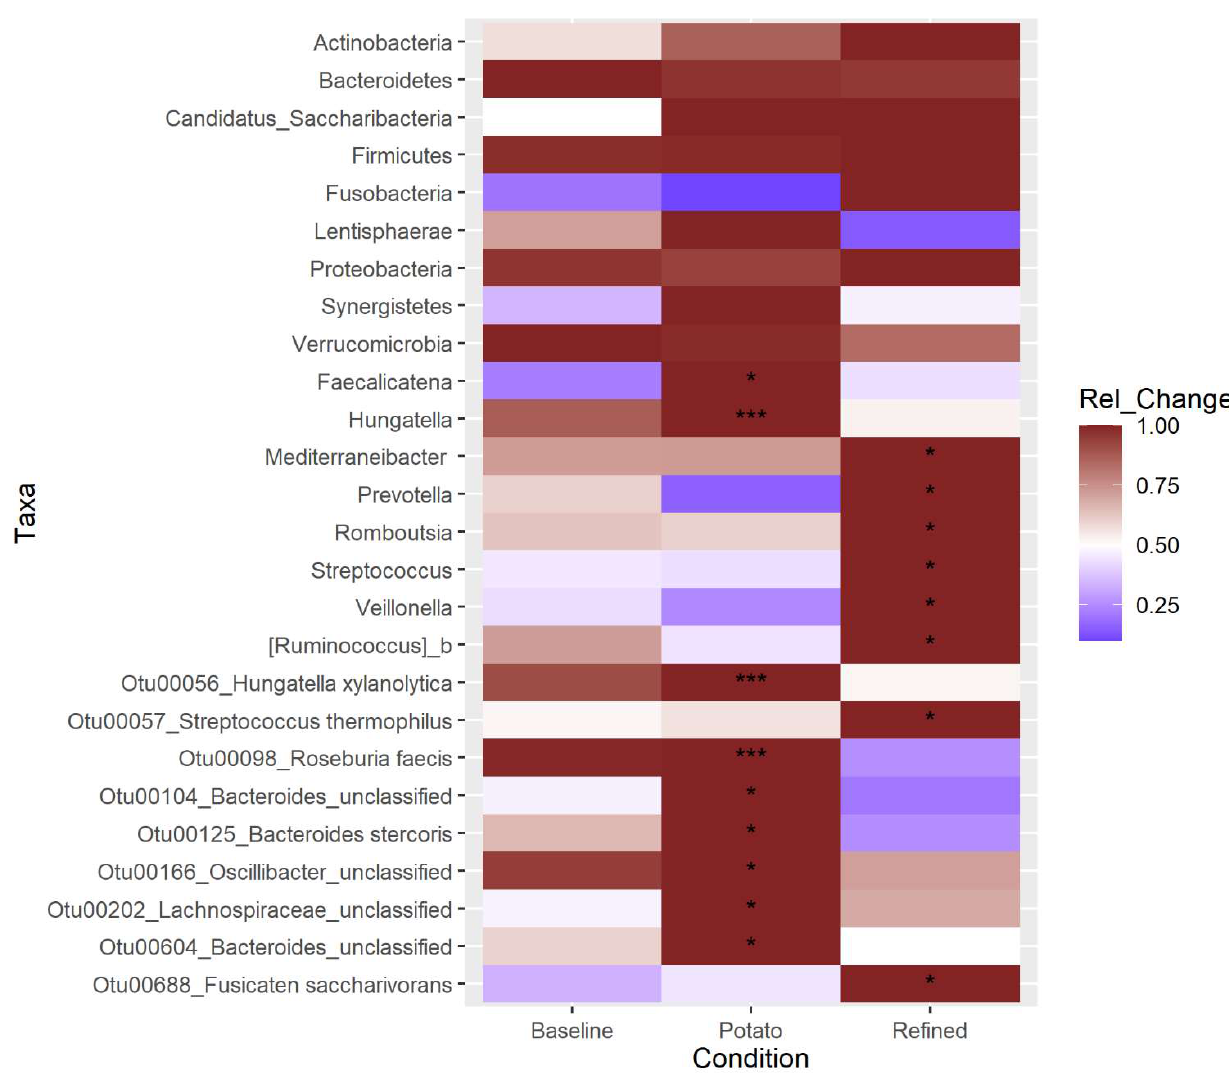
Figure 4. Differential abundance analysis. The heatmap is colored by the standardized change in the relative abundance of the taxon between the baseline and each of the diet conditions. Significant differences were calculated by three methods: LEfSe, DESeq2, and ANCOM-II. Significance is indicated by * for one method finding the taxon significantly different between that treatment and the control, *** for all three methods detecting a significant change. For LEfSe and DESeq2, adjusted p -values of 0.05 were used as the cutoff for significance, while for ANCOM-II, which does not generate P-values, the default cutoff threshold of 0.7 was used.